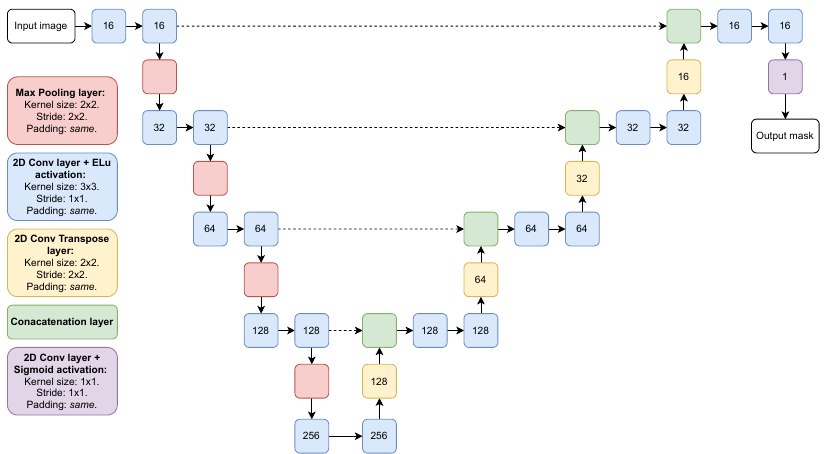
Figure 7. In-detail structure of the model proposed by Akhloufi et al. [38]. The numbers inside the squares represent the number of filters in the corresponding